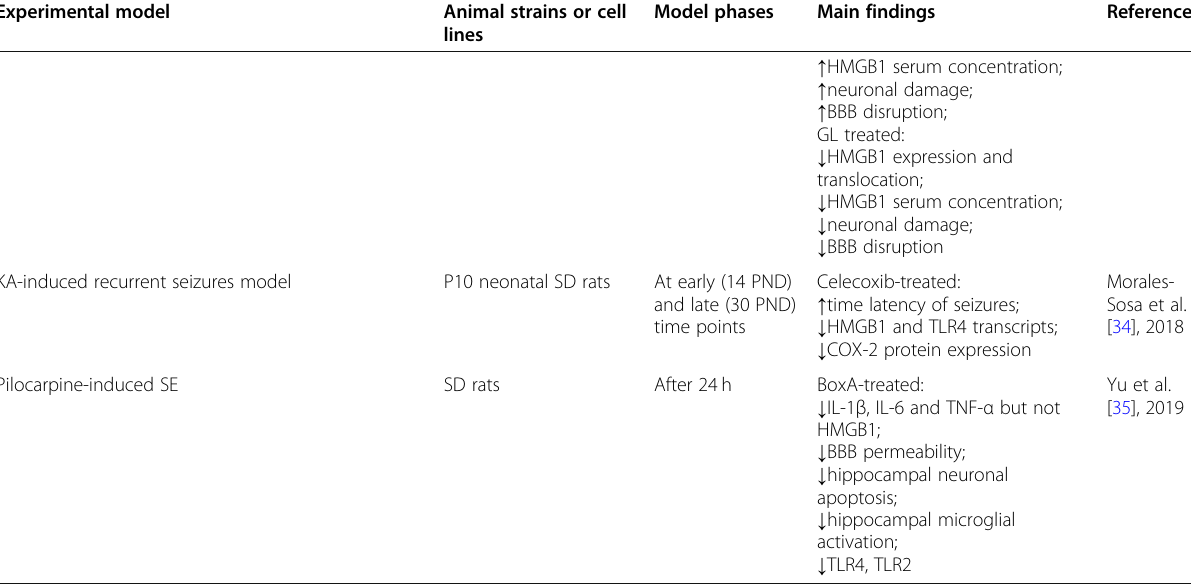
Table 2 HMGB1-related findings in experimental models of epilepsy (Continued) Experimental model Animal strains or cell